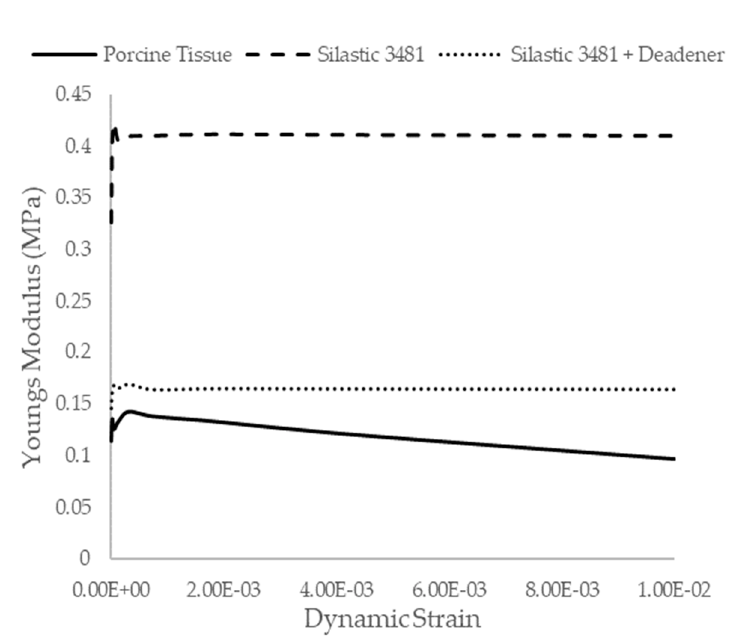
Figure 3. Strain sweep of Young’s modulus comparing porcine muscle, Silastic 3481 and Silastic 3481 plus